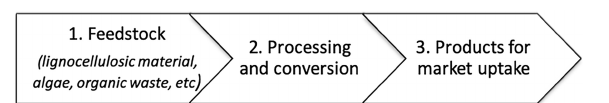
FIGURE 2 | Simplified scheme of a bio-based value chain. The figure represents a non-exhaustive description of the elements that are involved in the establishment of a bio-based value chain. Blocks indicate, respectively: sustainable biomass production and collection (block 1), breakthrough technology of processes and their conversion routes (block 2), and production of innovative added value products to the market (block